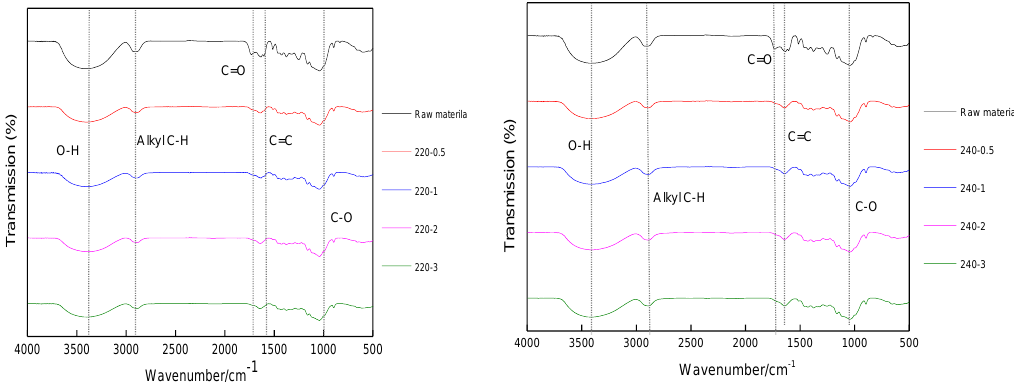
Figure 2. FTIR spectra of un-treated and glycerol pretreated corncobs.